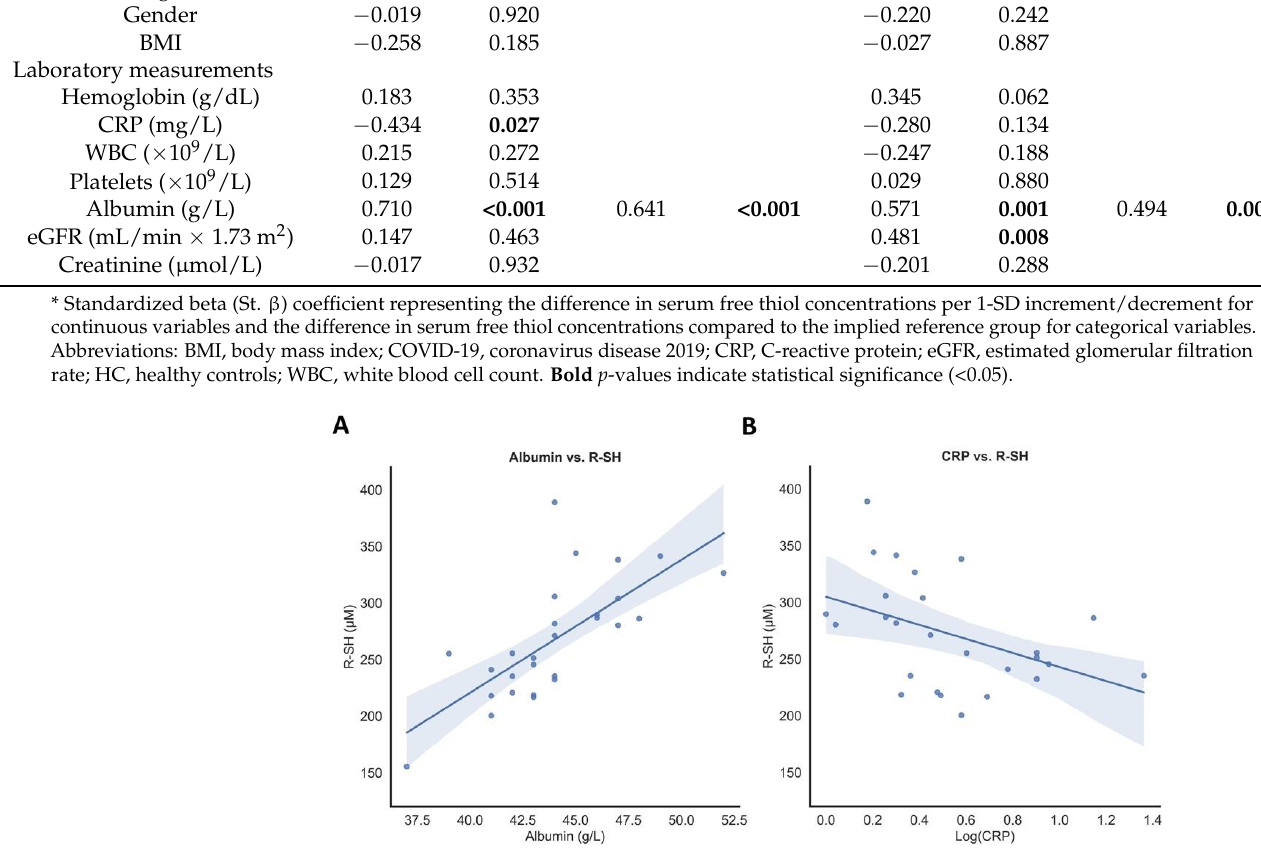
0.005 Data are presented as means ± SD, median [IQR] or proportions n with corresponding percentages (%). Red arrows indi- cate significantly reduced concentrations at day 7; green arrows indicate significantly elevated concentrations at day 7. Abbreviations: COVID-19, coronavirus disease 2019; CRP, C-reactive protein; eGFR, estimated glomerular filtration rate; HC, healthy controls; WBC, white blood cell count. Bold p -values indicate statistical significance (<0.05). No statistically significant difference in baseline serum free thiol concentrations was found between subjects who eventually required hospitalization (262.1 [206.4 – 268.1]) and those non-hospitalized (255.5 [233.8 – 296.8], p = 0.325). Hospitalized COVID-19 patients